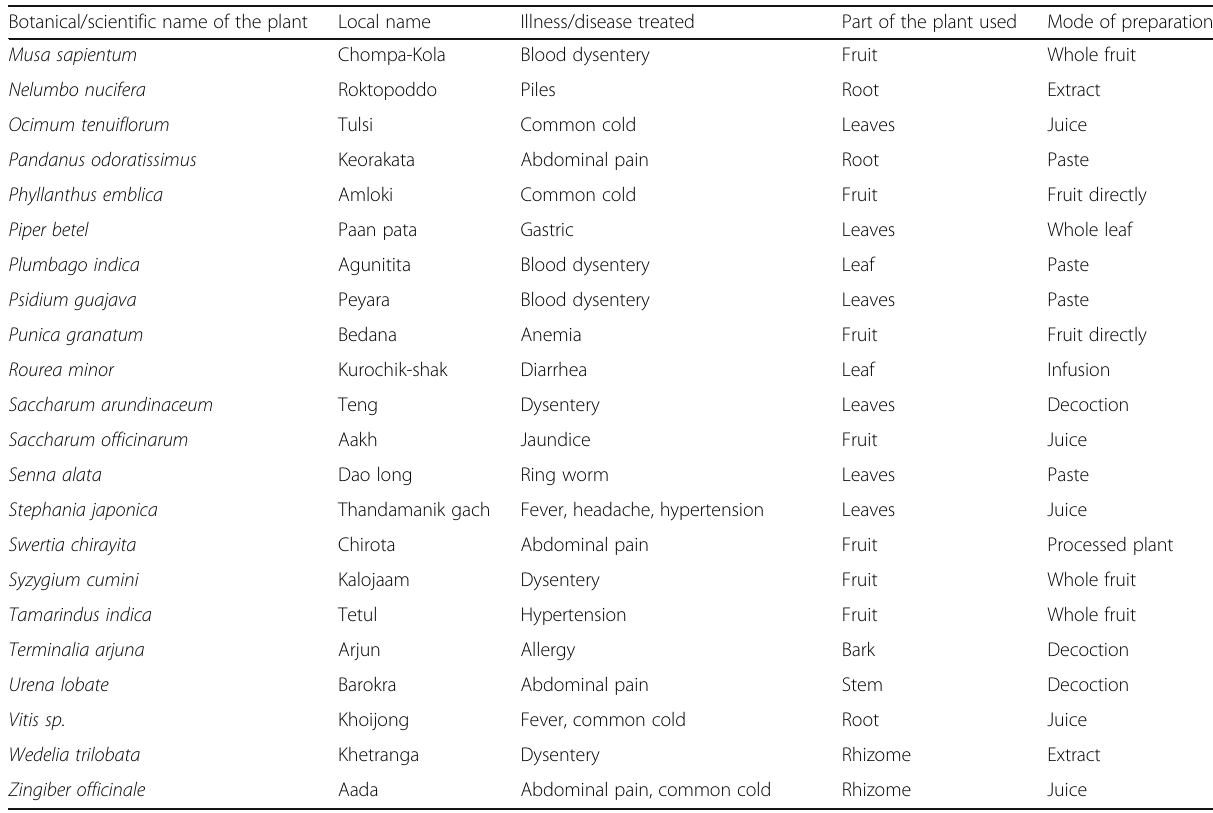
Table 2 Ethnomedicinal plants used by the tribal people of Rangamati for treating different diseases (source: Medicinal Plants Database of Bangladesh [24 – 26]). A total of 62 medicinal plant species were found out of which 26 plants treat gastrointestinal ailments (GIA), 12 plants treat respiratory system disorders (RSD). Poisonous bites (PB) and skeleton muscular system disorders (SMSD) were treated by 2 plants. Endocrinal disorders (ED), throat pain, and hemorrhoids (HEM) were healed by 3 plants. Four plants were used to cure different types of fever (Fvr). For liver problems (LP), 5 plants were used. Dermatological infections/diseases (DID) were treated using 9 different plants. Three plants were used to treat hypertension (HTN) and 2 were used to treat anemia